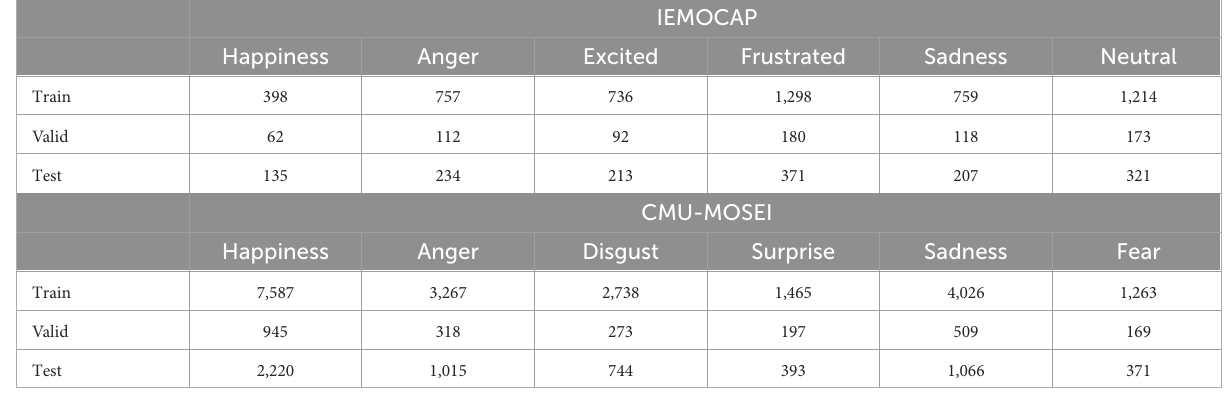
TABLE 1 Statistics of the IEMOCAP and CMU-MOSEI datasets used in this work.